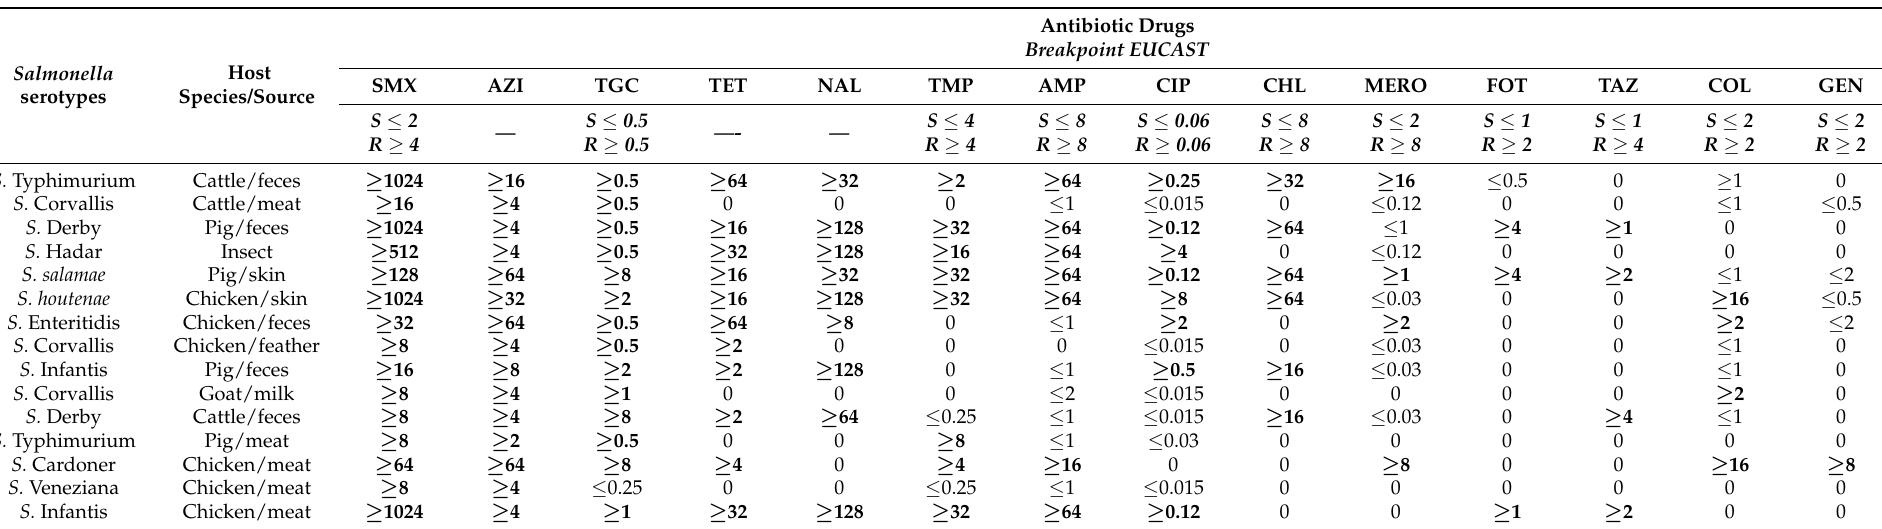
Table 2. Antibiotic susceptibility results for Salmonella serotypes from different hosts and sources, obtained by means of the minimum inhibitory concentration